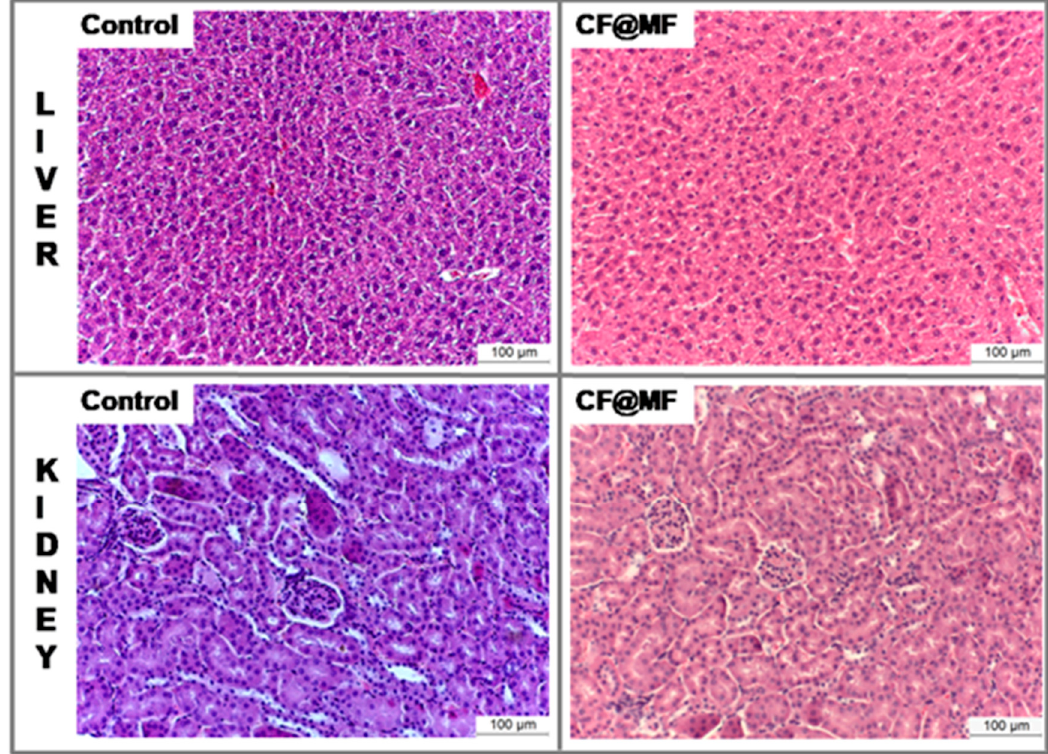
Figure 9. Haematoxylin and eosin representative histological sections of control liver ( a ), liver at 24 h post-injection of PEGylated CF@MF NPs ( b ), control kidney ( c ), and kidney at 24 h post-injection of PEGylated CF@MF NPs ( d ).